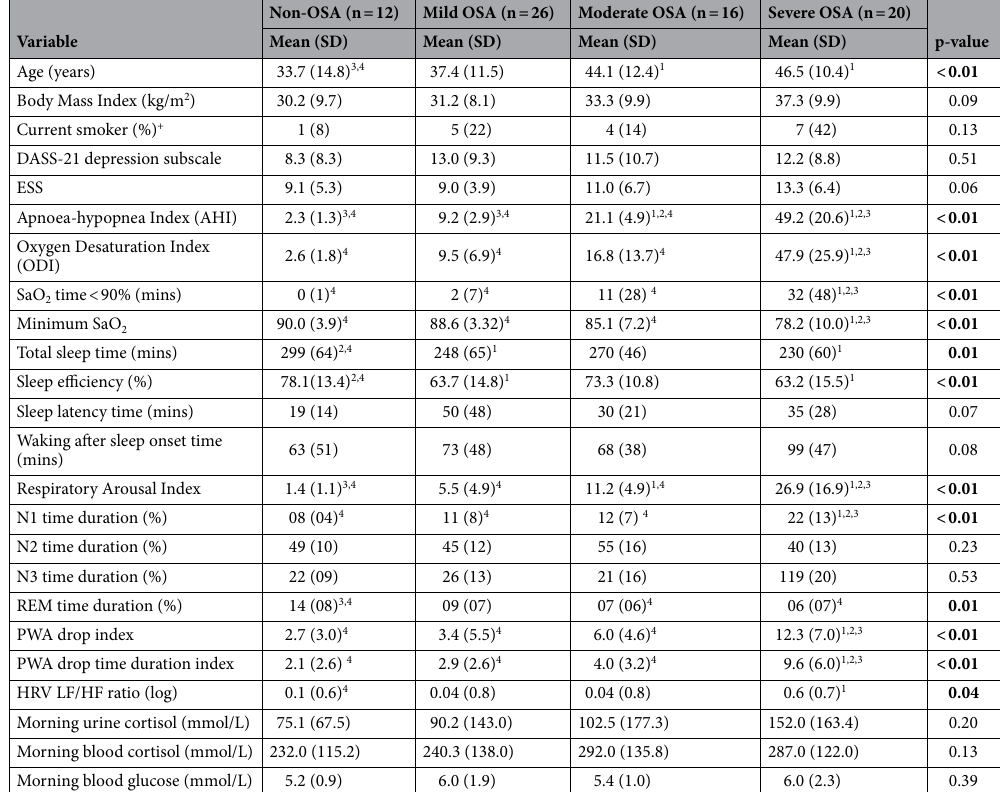
Table 1. Comparison of demographic variables, depression, daytime sleepiness, polysomnography parameters and nocturnal sympathetic nervous system indices by OSA severity group. OSA severity cut-off values